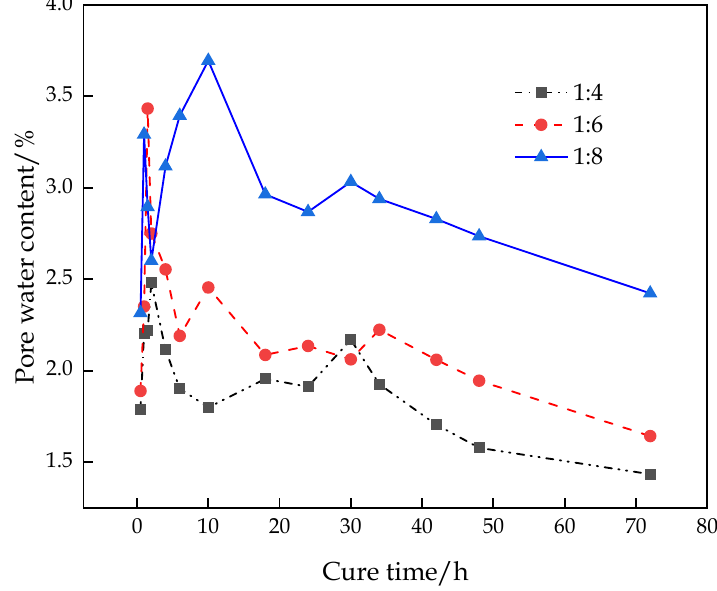
Figure 8. Characteristic curve of pore water moisture variation.